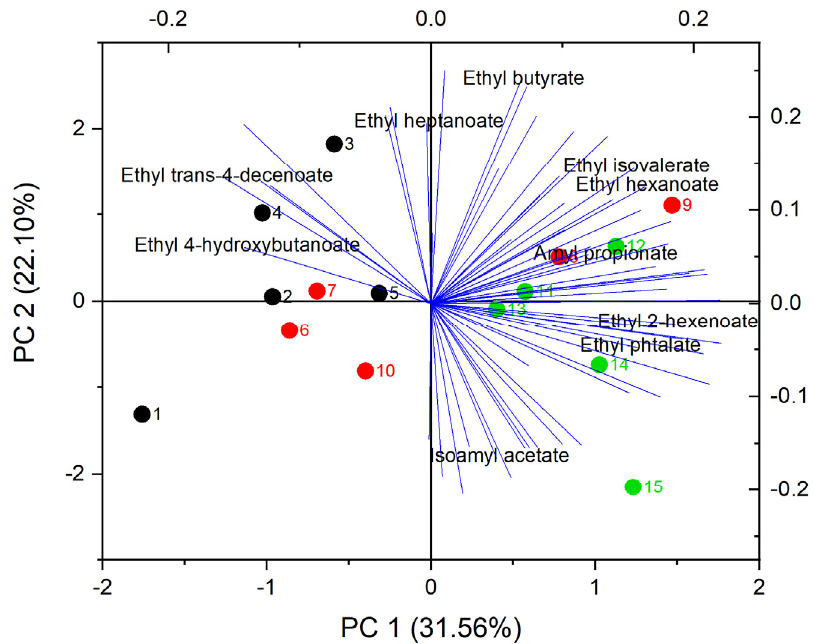
Figure 6. PCA for esters in Cabernet Sauvignon wines produced by supplemented fermentations with different nitrogen sources. Samples 1 to 5 are DAP (black), 5 to 10 are LDH (red), and 11 to 15 are HDH (green).